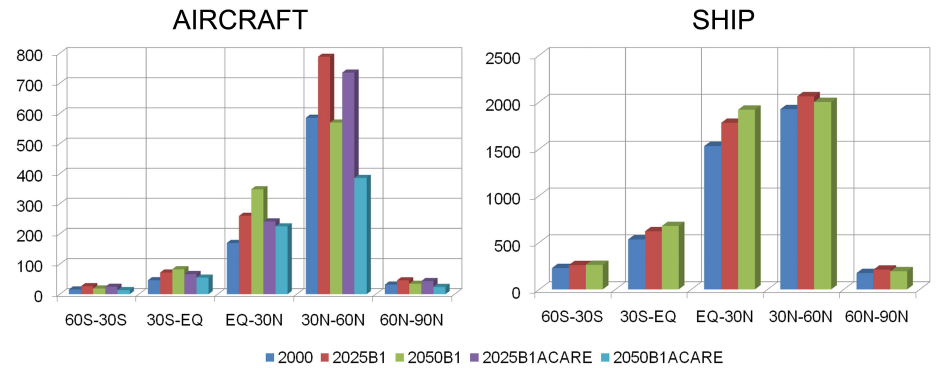
Fig. 4. NO x emissions (Gg(N) yr − 1 ) from aircraft (left) and shipping (right) for different latitude intervals and for different years/scenarios. Note that 90 ◦ S–60 ◦ S is not shown in the figures because the emissions in this region are close to